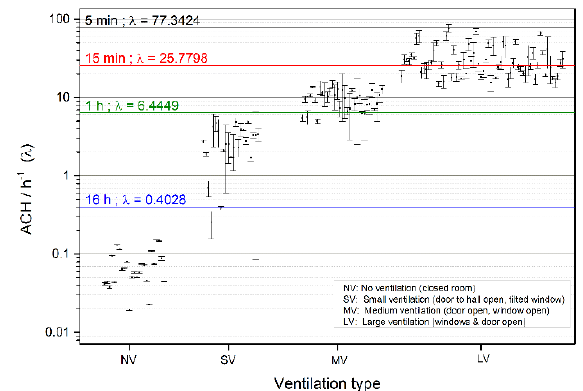
Figure 8. Air change rate as a function of the type of ventilation as well as the threshold ventilation rate required to achieve good IAQ. The results show that a 5 minute break is not sufficient to reestablish good IAQ. Only after 15 min of ideal and strong ventilation may low CO 2 levels be achieved.